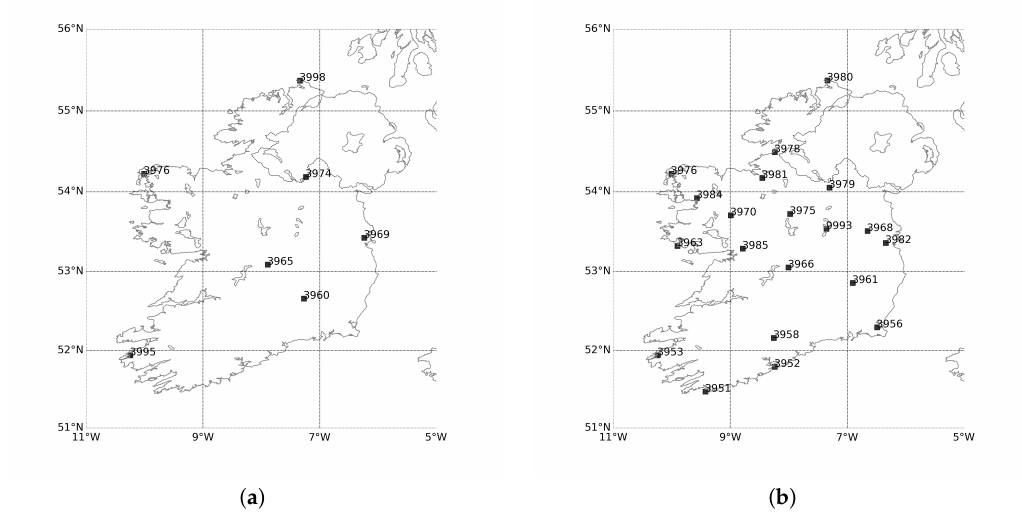
Figure 1. ( a ) Original network of global horizontal irradiance (GHI) measuring stations in Ireland. ( b ) Current network of automatic GHI stations in